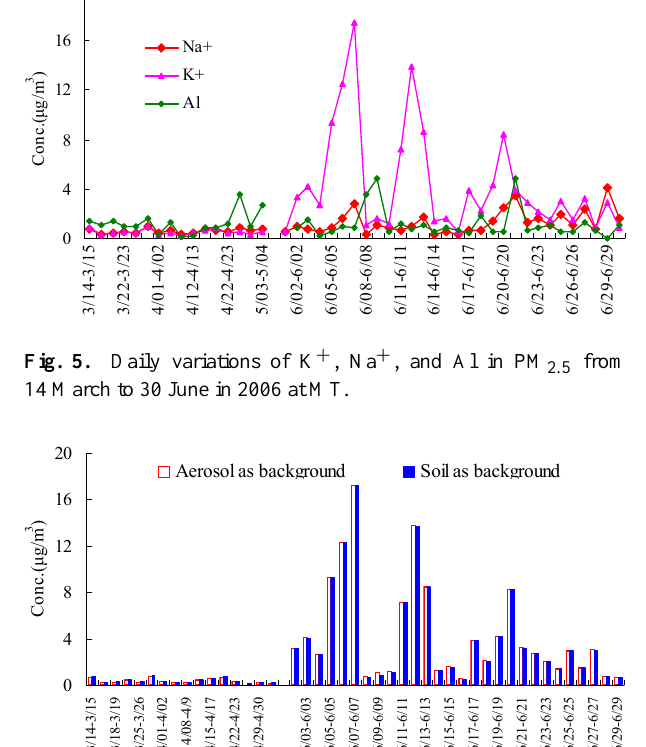
Fig. 6. Concentrations of biomass burning derived K + calculated with two methods in PM 2.5 in 2006 at MT.